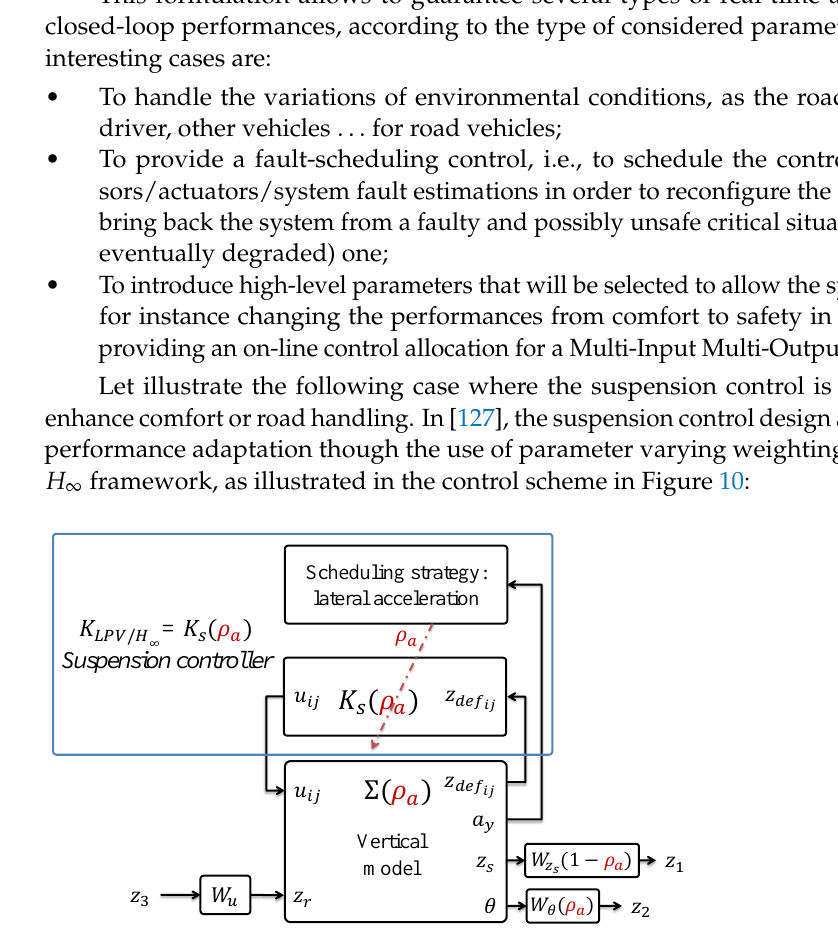
Figure 10. Diagram block of the LPV/ H ∞ suspension